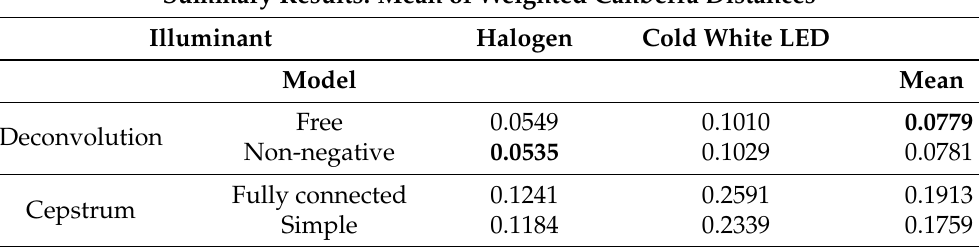
Table 2. Summary results of the means of weighted Canberra distances between estimated and ground truth spectra for illuminant, method, and model combinations averaged over cameras. The best result is indicated in